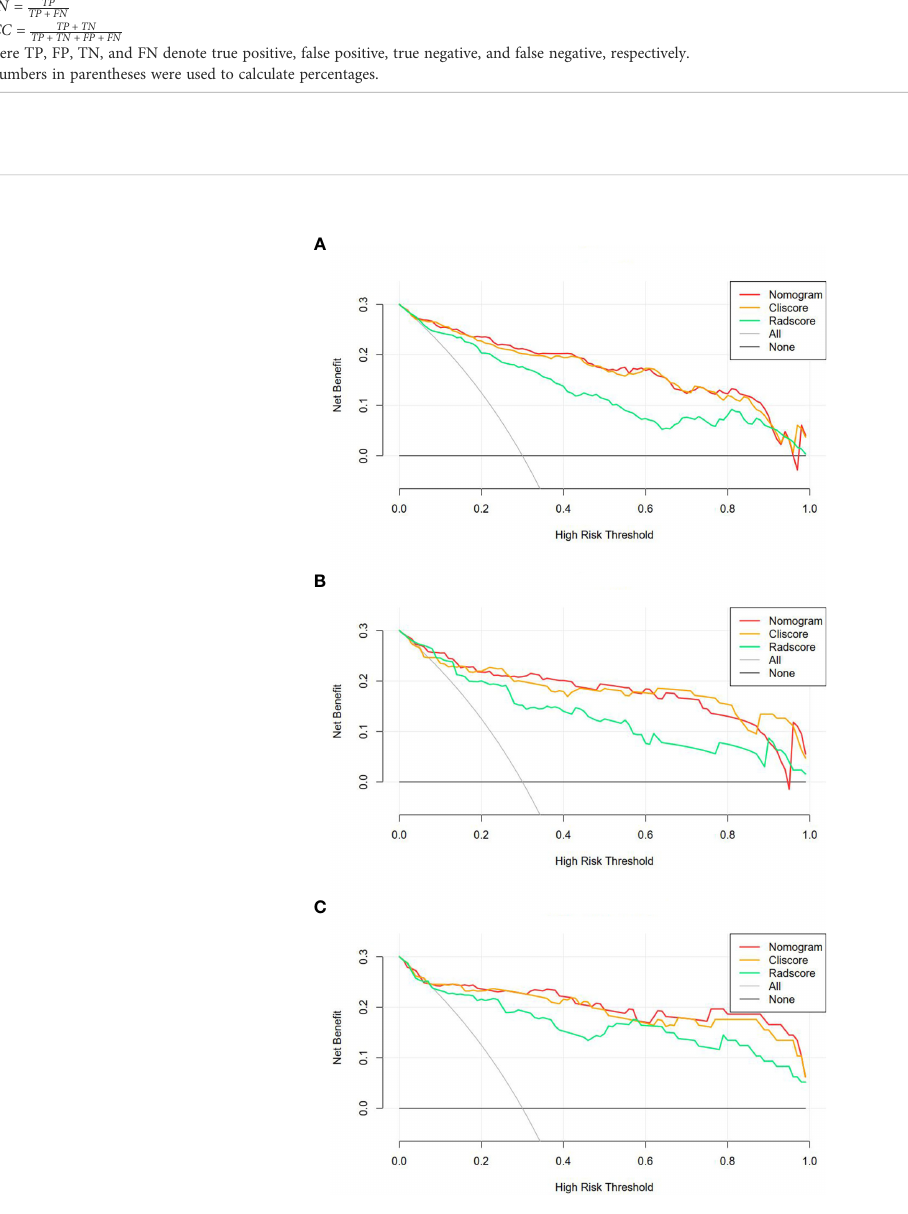
FIGURE 6 Decision curve analysis for the three models in the training (A) , internal validation (B) and external validation (C) cohorts. The y-axis shows the net bene fi t; x-axis shows the threshold probability. The red, orange, and green line represent net bene fi t of the radiomics nomogram, clinical factors model, and radiomics signature,